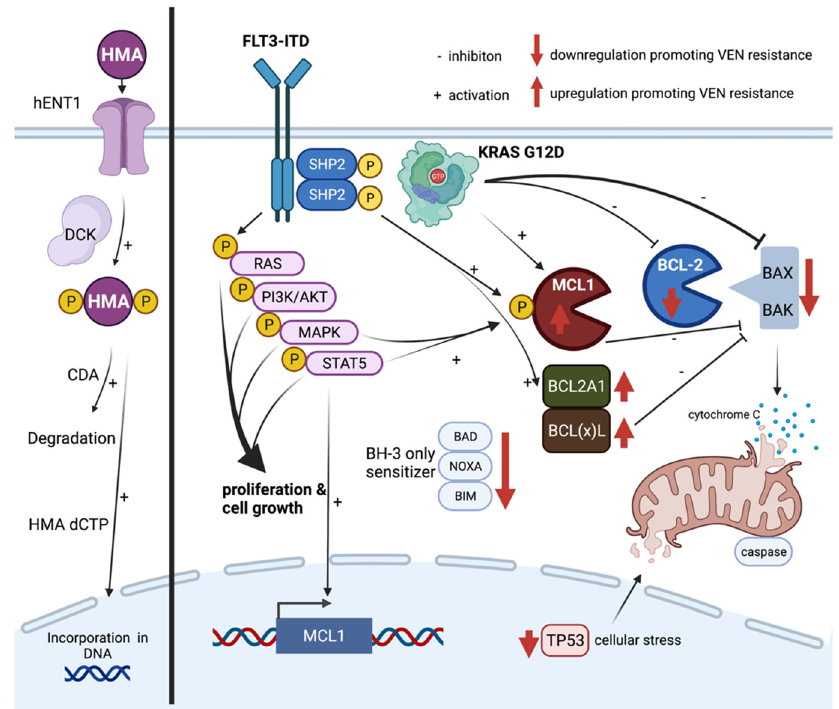
Figure 1. Mechanisms of resistance towards venetoclax. Left: uptake, processing, and incorporation of HMAs into the leukemic cell are illustrated. Cellular uptake of HMAs mainly depends on cell surface hENT1 receptor expression. Phosphorylation to active cytosine di- and triphosphatases is mediated by DCK , whereas low expression and diminished activity contributes to decreased HMA effect. Augmented enzymatic degradation of dCTPs also contributes to degraded HMA effect. Right: regulation and interactions of proteins that are responsible for venetoclax resistance are shown. Balance between multiple BCL-2 members within the concert of intrinsic apoptosis pathways is pivotal. Downregulation of BCL-2 reduces venetoclax sensitivity as well as reduced activation of mitochondrial apoptosis effectors BAX and BAK. KRAS mutations mediate such gene expression alterations. Upregulation of important anti-apoptotic genes like MCL-1 , BCL2A1, and BCL ( x ) L causes venetoclax resistance by binding and sequestering the effectors BAX and BAK . Activation and upregulation are driven by activating mutations of FLT3-ITD , SHP2, or KRAS . Especially consecutive STAT5 signaling can directly upregulate MCL-1 by activating an MCL-1 promotor. BH3 - only proteins acting as pro-apoptotic sensitizers bind pro-apoptotic members causing configuration changes and release of BAX and BAK . Mutations in TP53 can reduce its function as tumor suppressor and confer alterations of expression of BCL-2 family members. One consequence of TP53 deletion is an increase of cellular stress, which is known to contribute resistance towards different cancer drugs. Created with BioRender.com. Abbreviations: HMA hypomethylating agent; hENT1 human equilibrated nucleoside transporter-1; DCK deoxycytidine kinase; CDA cytidine deaminases; dCTP deoxycytidine triphosphate; FLT3-ITD FMS-like tyrosine kinase receptor III with internal tandem duplication; SHP2 SH2 containing protein tyrosine phosphatase-2; BCL-2 b-cell lymphoma 2; MOMP mitochondrial outer membrane permeabilization; KRAS Kirsten rat sarcoma virus; MCL-1 induced leukemia cell differentiation protein; BCL2A1 BCL-2 related protein A1; BCL(x)L b-cell lymphoma extra-large; STAT5 signal transducer and activator of transcription 5; TP53 tumor protein p53; VEN